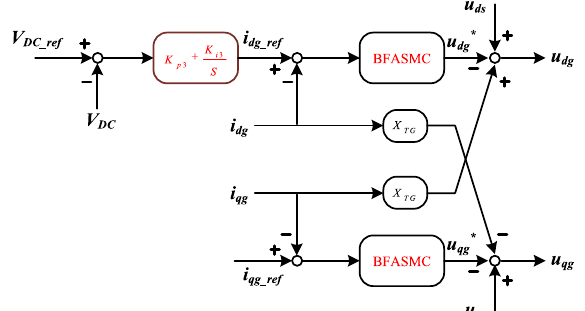
Fig. 3 Modified grid side controller